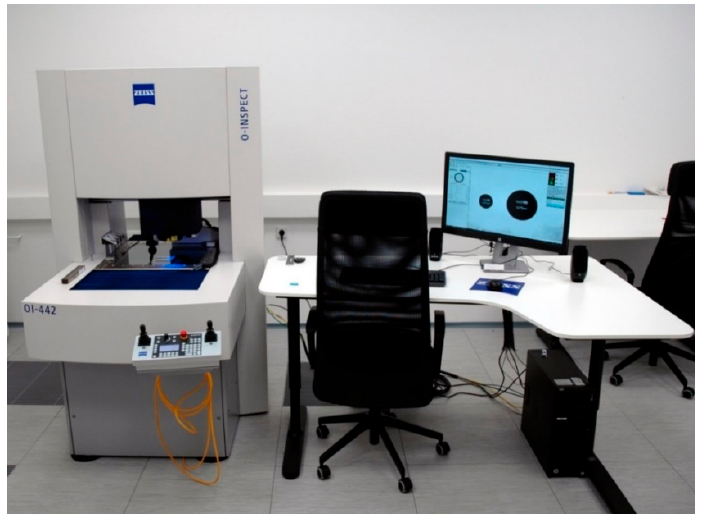
Figure 3. Zeiss O’ Inspect 442 used during experiments, located at the Laboratory of Coordinate